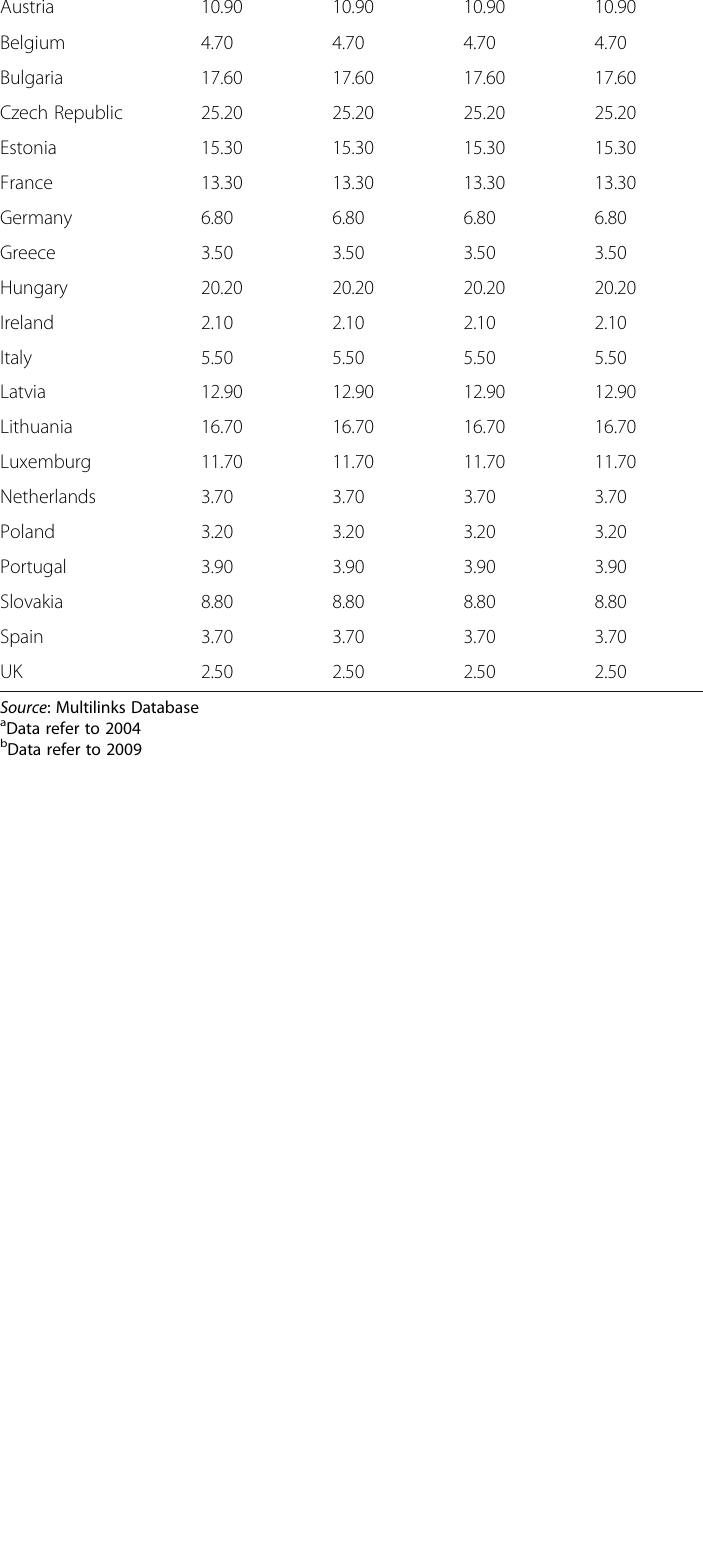
Table 6 Total leave-time in months weighted by payment level